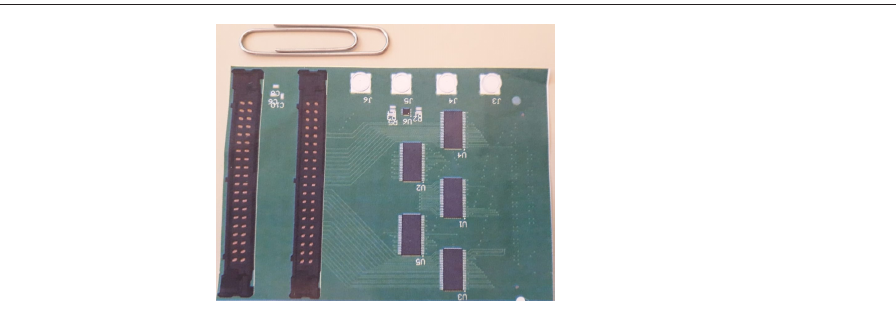
Figure 3. Life-size cut-out of the TTC interface card. Table 2. Resource occupancy of the Ultrascale + FPGA for the core trigger processor functionalities in the L0TP +